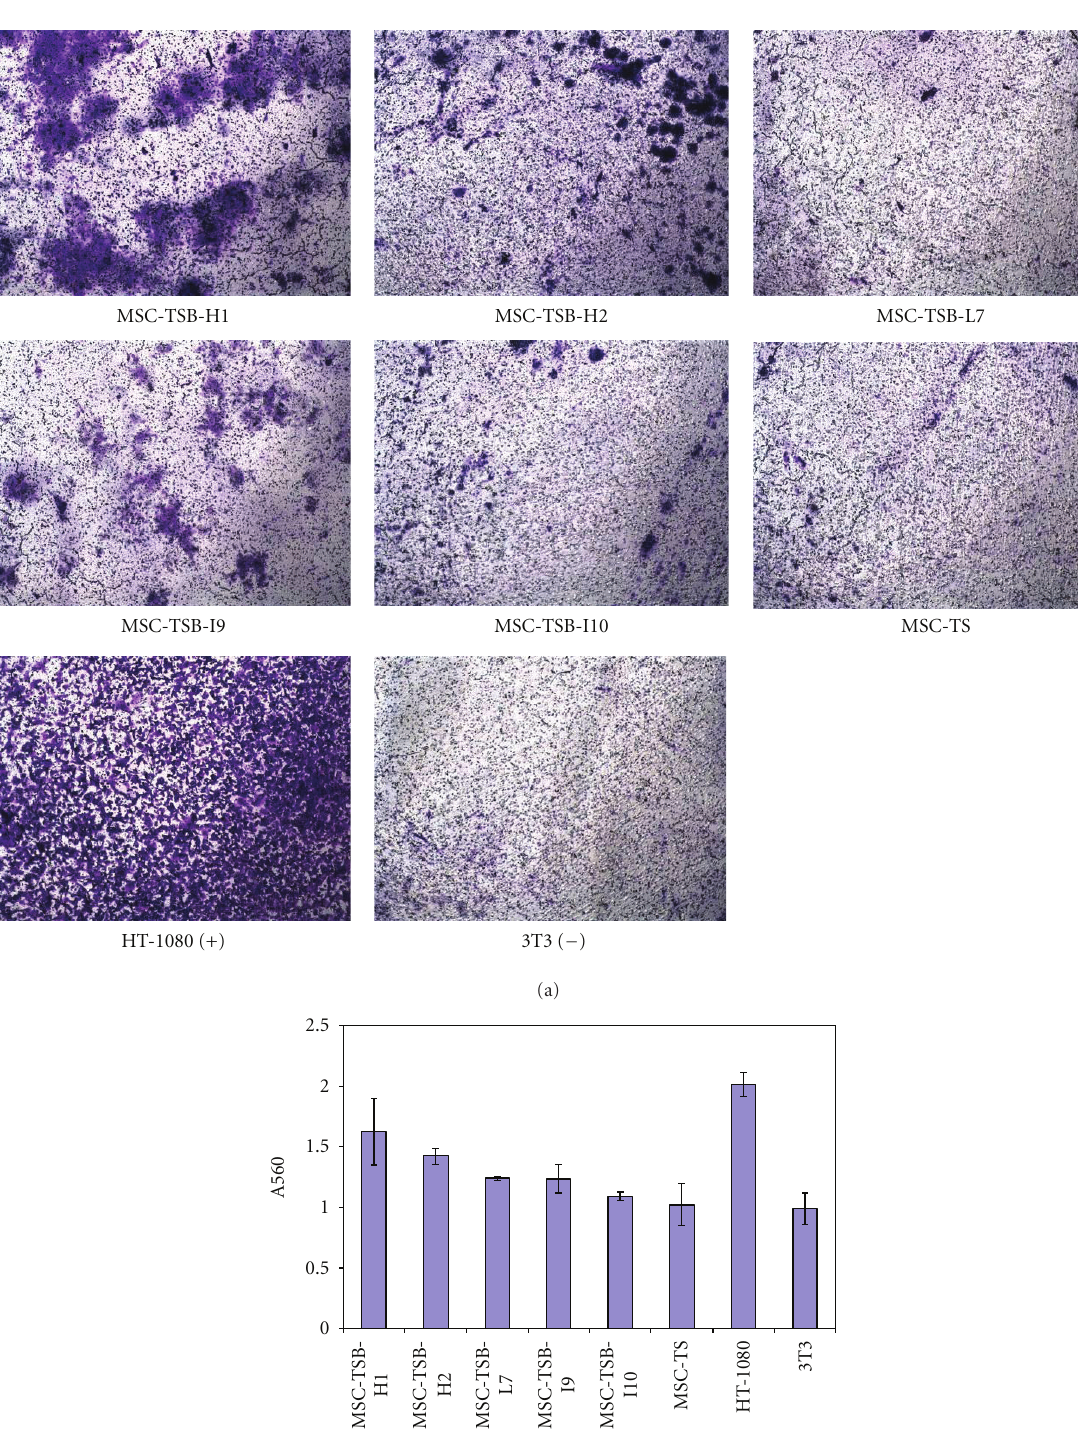
Figure 4: Cell invasion assay. (a) Pictures taken under microscope after staining (10x magnifications) to visualize the invasive cells across the polycarbonate membrane. (b) A summary of the invasion assay results after staining and extracting the cells outside the membrane. The highly invasive HT-1080 cell lines served as a positive control, and the noninvasive NIH-3T3 (3T3) cells served as a negative control. There is no statistically significant di ff erence between the transformed clones with di ff erent β -catenin level and the parental MSC-TS, all P values are greater than